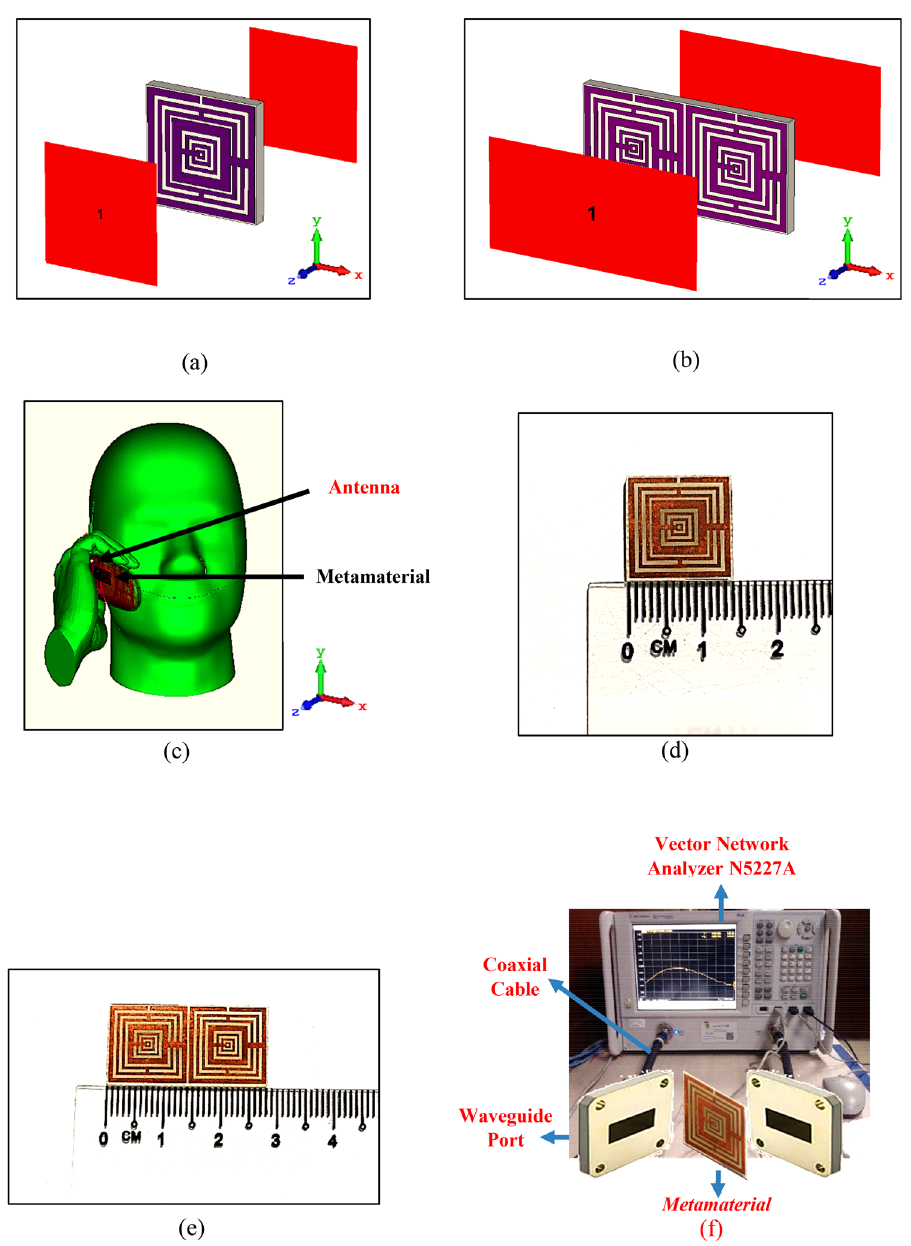
Figure 2. Numerical simulation, fabrication, and measurement: ( a ) unit cell SM metamaterial, ( b ) 1 × 2 array SM metamaterial, ( c ) fabricated unit cell SM metamaterial, ( d ) fabricated 1 × 2 array SM metamaterial, ( e ) voxel human model, ( f ) metamaterial measurement setup of Vector Network Analyzer